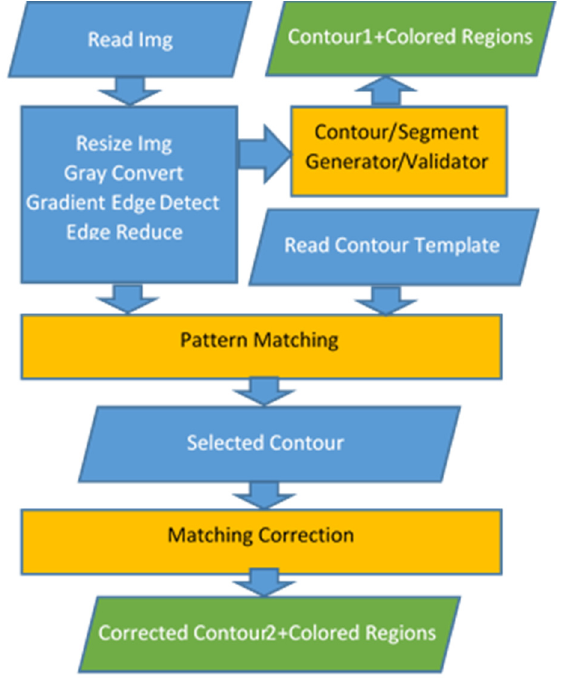
Figure 1. The image processing flow.